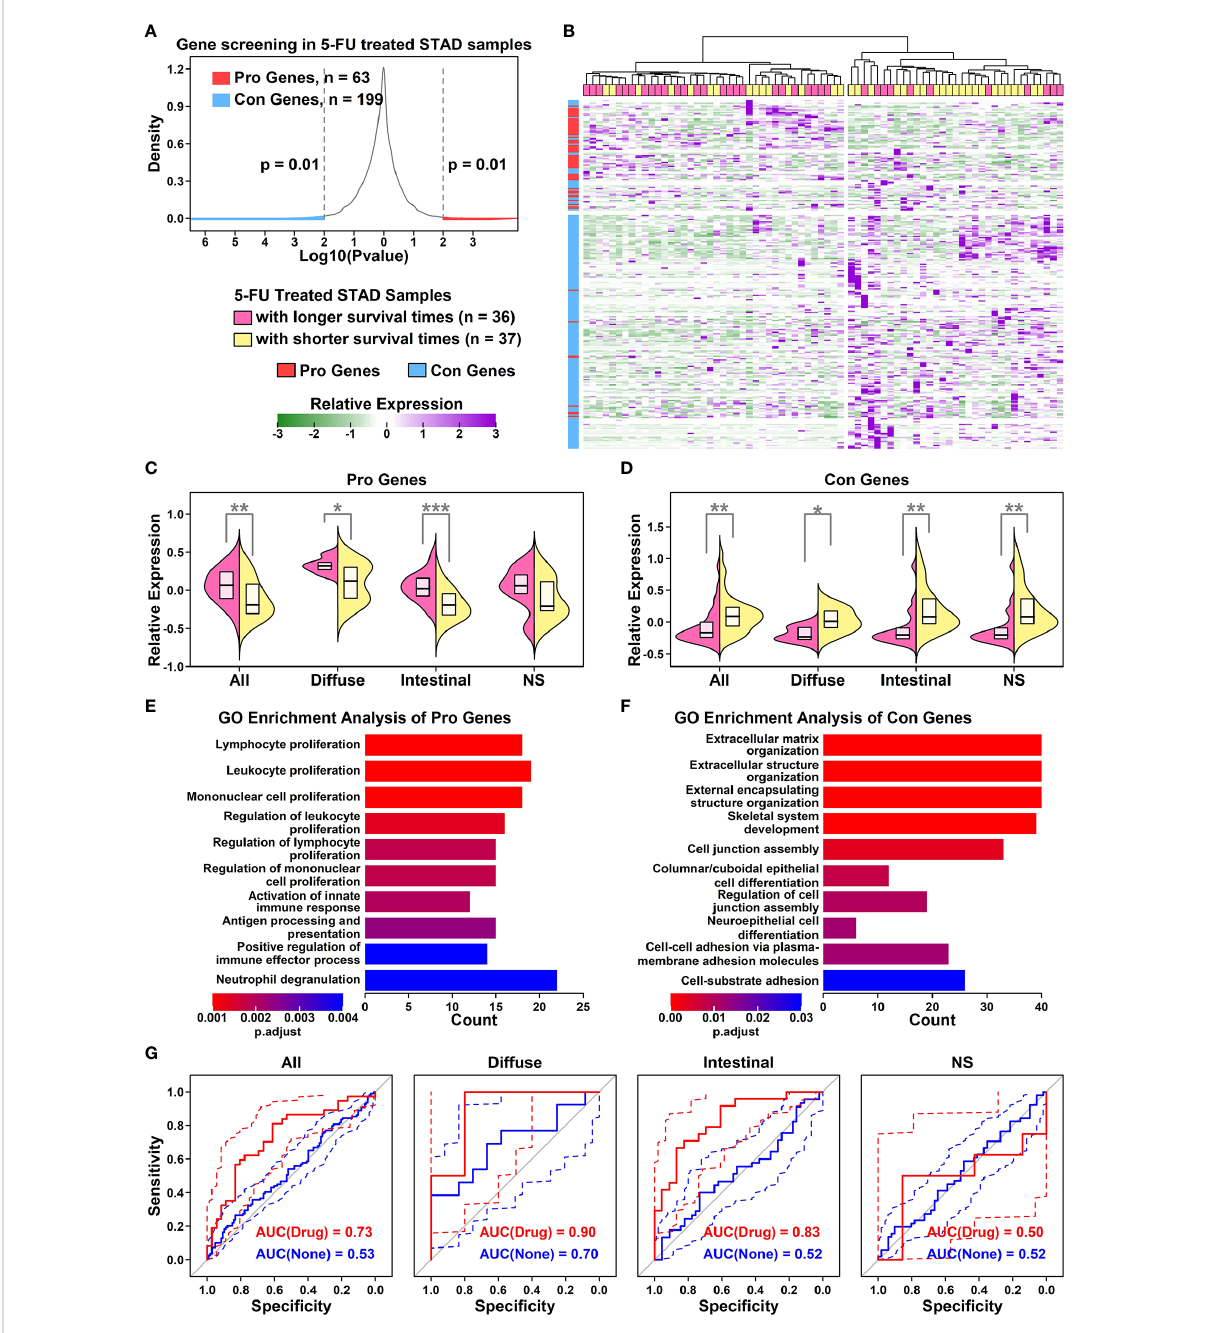
FIGURE 2 Establishment of a Pro and Con gene cohort (A) Density plot showing the p value distribution of genes in the survival analysis of 5-FU treated STAD samples. x-axis represents the log10 p value of each input gene in Kaplan-Meier analysis, and y-axis represents the density distributions of all p values; (B) Heatmap representing relative expression values of Pro (red) and Con (blue) genes across all 5-FU treated STAD samples. Pink represents 5-FU treated STAD samples with longer survival times (> median), and yellow represents 5-FU treated STAD samples with shorter survival times (<= median); (C) Dual violin plot showing the relative expression values of Pro gene cohort across samples of different GC subtypes (* p < 0.05; ** p < 0.01; *** p < 0.001. Two-tailed t-test); (D) Dual violin plot showing the relative expression values of Con gene cohort across samples of different GC subtypes. A two-tailed t-test was used(* p < 0.05; ** p < 0.01; *** p < 0.001. Two-tailed t-test); (E) Top 10 enriched GO terms of Pro genes; (F) Top 10 enriched GO terms of Con genes; (G) ROC curves representing the separation ability of Pro and Con gene cohort in separating different subtypes of 5-FU-bene fi t samples from 5-FU-futile